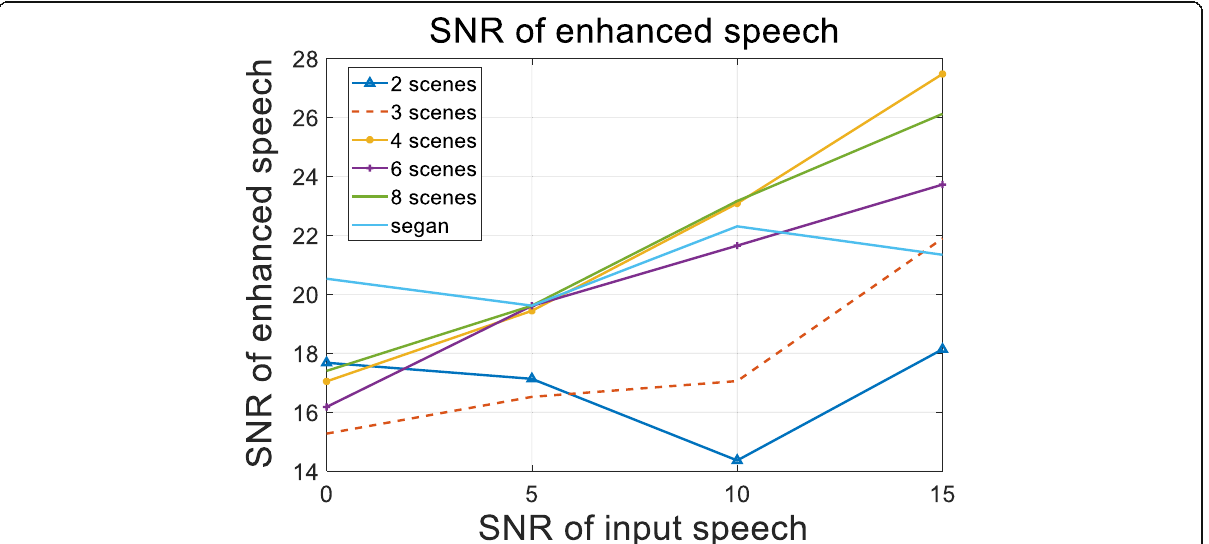
Fig. 6 The SNR of enhancement speech. It depicts the SNR of speech enhancement signal of test data in improved WCGAN models with different numbers of scenes and SEGAN model with the average SNR. We find surprisingly that the improved model achieves mean value 23.65 gain in the SNR on WCGAN and achieves 21.05 gain on